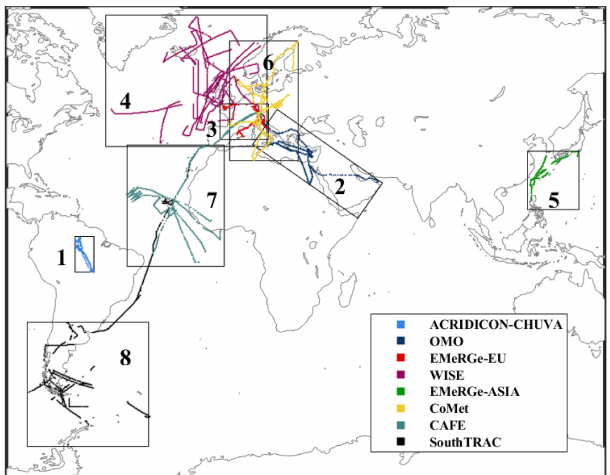
Figure 3. The different geographical regions and the flight tracks covered during the eight missions. For simplicity, the missions are numbered according to their chronological order as follows: ACRIDICON-CHUVA (1), OMO (2), EMeRGe-EU (3), WISE (4), EMeRGe-Asia (5), CoMet (6), CAFE-Africa (7), and SouthTRAC (8). The operational bases for the individual missions were Man- aus (Brazil) for ACRIDICON-CHUVA, Paphos (Cyprus) for OMO, Oberpfaffenhofen (Germany) for EMeRGe-Europe and CoMet, Shannon (Ireland) for WISE, Tainan (Taiwan) for EMeRGe-Asia, and Rio Grande (Argentina) for SouthTRAC. Only flight sections with mini-DOAS measurements are